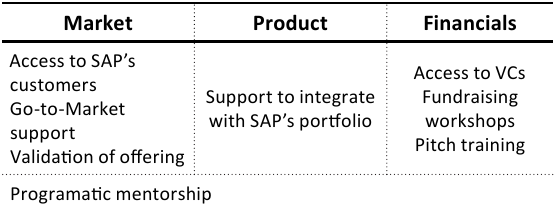
Table 1. Offerings for participating startups